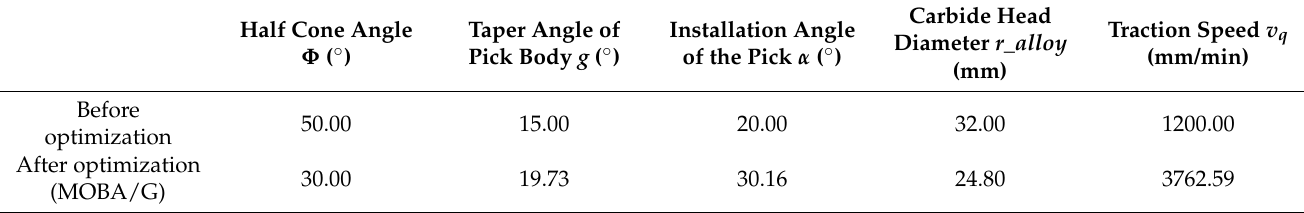
Table 4. Design variables before and after